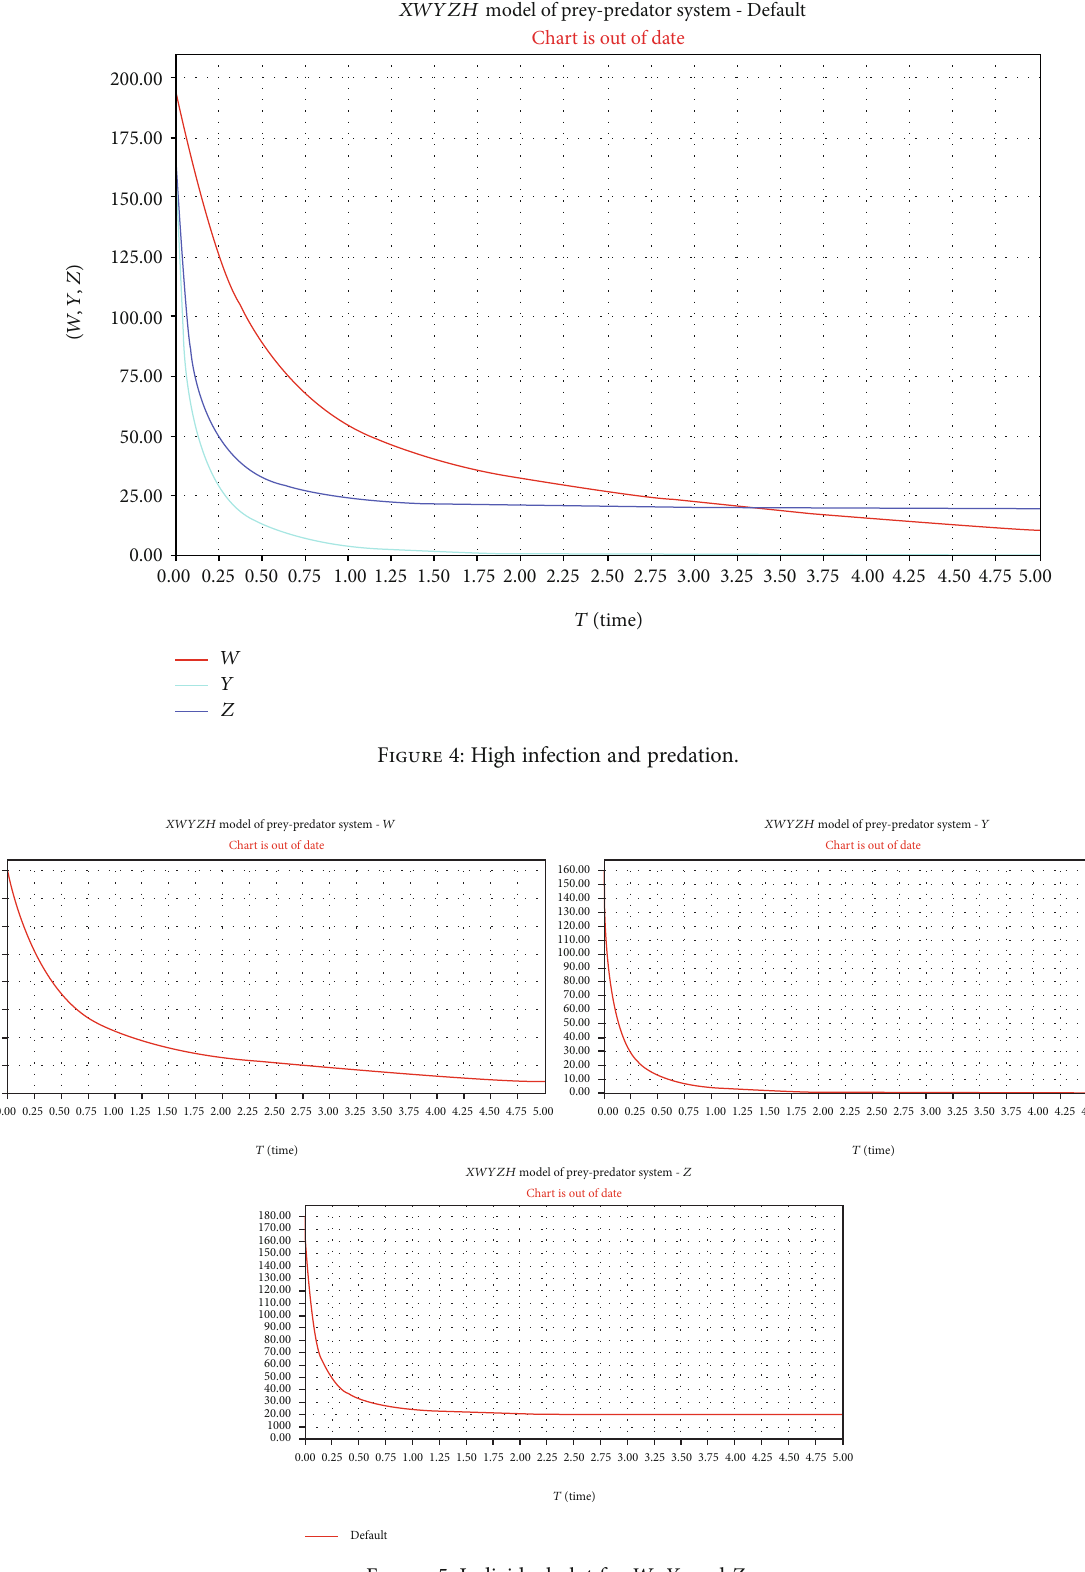
Figure 5: Individual plot for W , Y , and Z